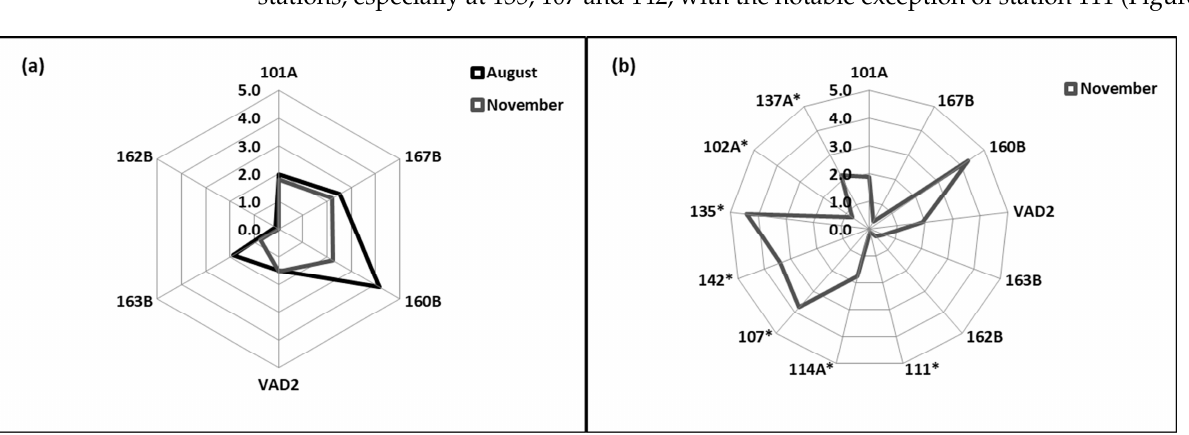
9 of 14 Figure 4. Spearman’s rank correlation coefficients between biomarker levels and physicochemical variables were calculated for six coastal stations in August and November, and for seven deep-water